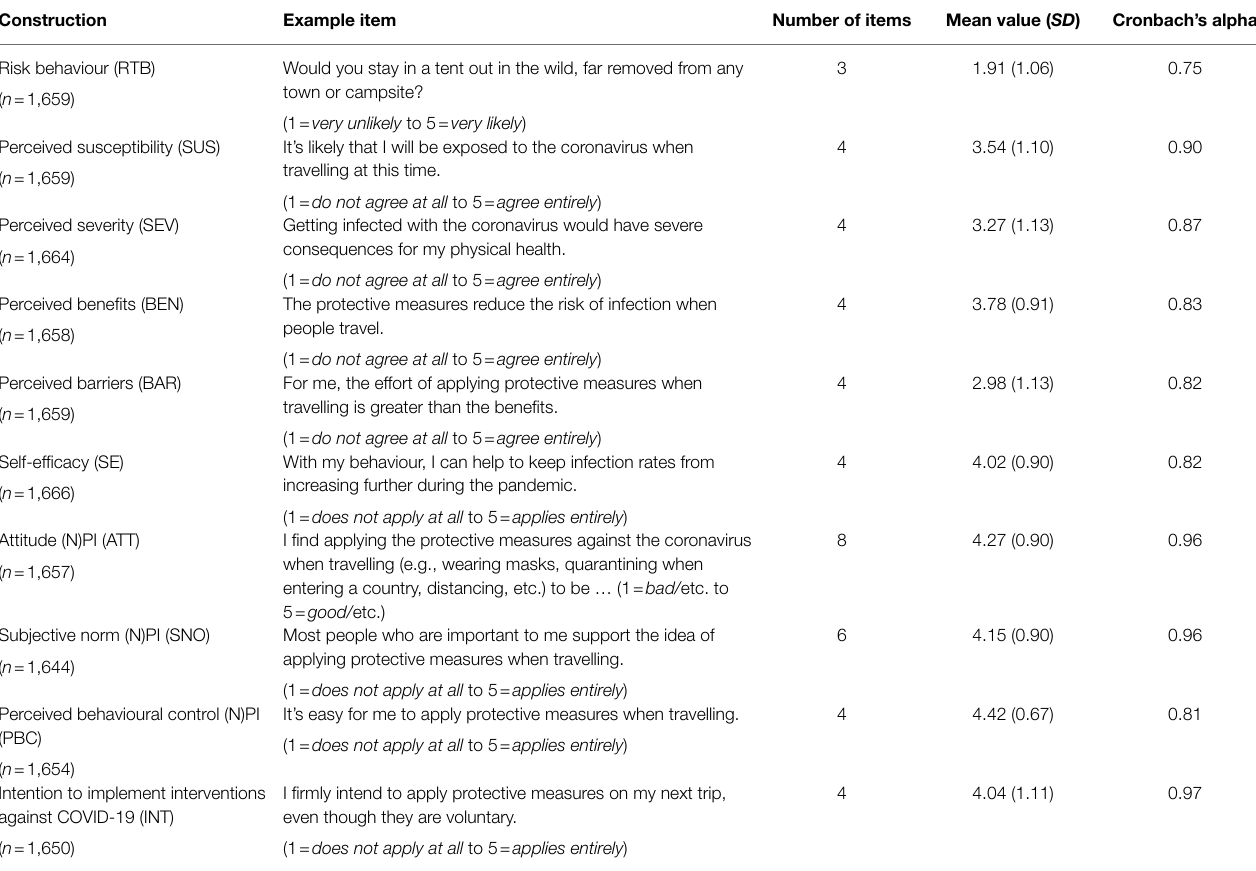
TABLE 3 | The dimensions of the explanatory model and an associated example item for each model.